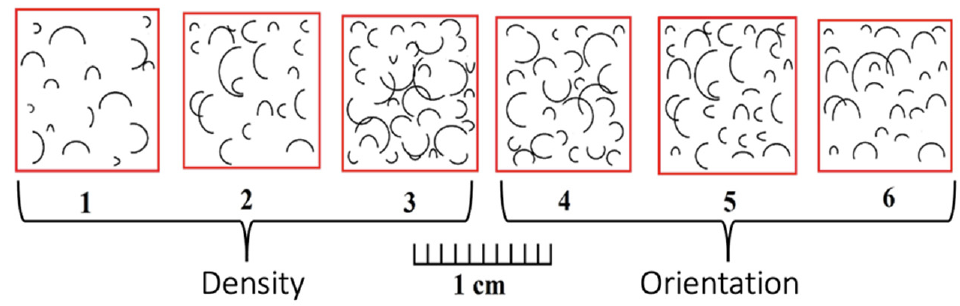
Figure 2. Graphical scheme used for the description of the density and orientation of surface marks 1 = <50 cm − 2 , 2 = 50 to 100 cm − 2 , 3 = >100 cm − 2 , 4 = isotropic, 5 = intermediate, 6 = oriented. The experimental work was carried out inside a wooden box 100 cm long, 60 cm wide and 10 cm high, half-filled with water. This box was connected to a three-phase motor type ML 7114, with 220 V and 1370 rpm. The equipment has a series of pulleys to decrease the angular velocity and a pulley with an eccentric connector to transform the rotary movement into an oscillating one. To facilitate the oscillating movement of the